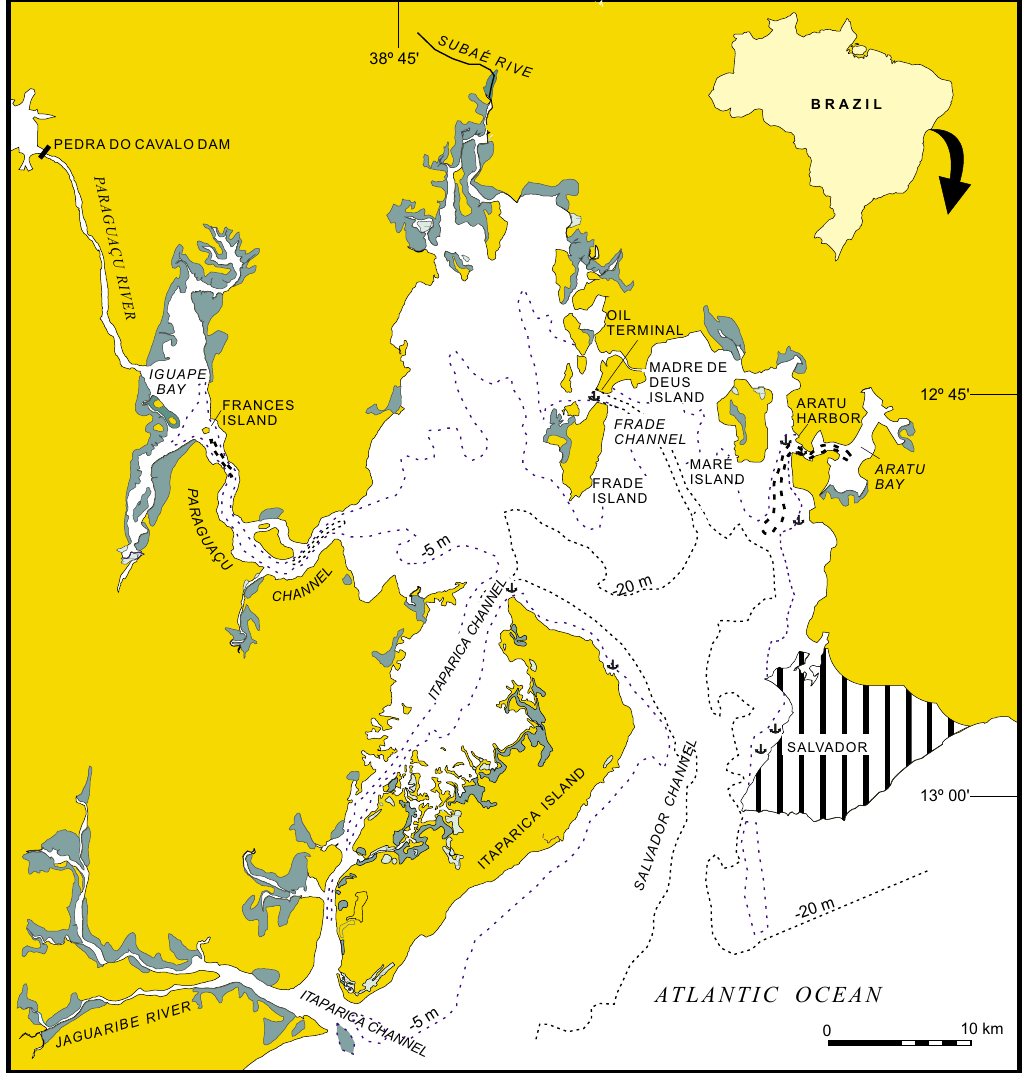
Fig. 1 – Location map of Todos os Santos Bay and general bathymetric contour. Darker areas are intertidal mangrove vegetation and small symbols locate maritime terminal facilities of various